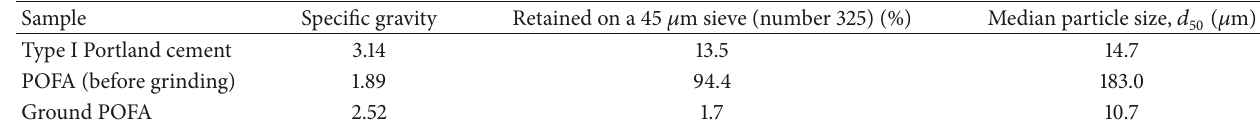
Table 1: Physical properties of the materials.